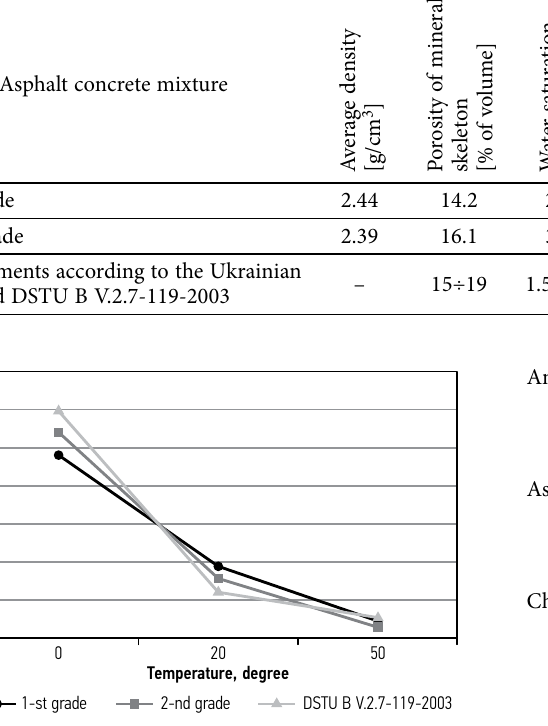
Fig. 5. Changes in compressive strength limit of asphalt concrete of 1-st grade and 2-nd grade, depending on temperature